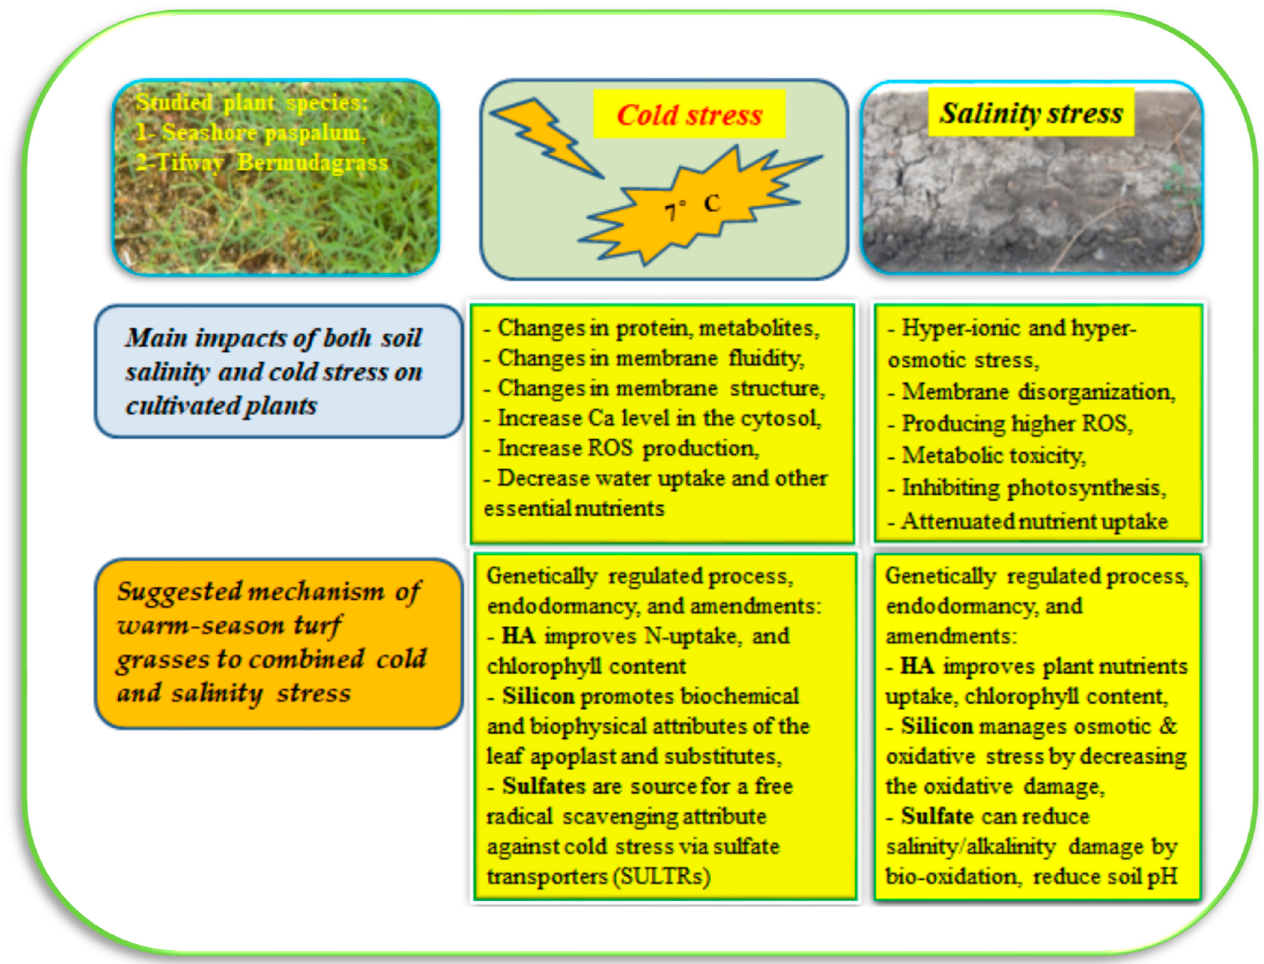
Figure 6. An overview of the suggested main damage to studied plants resulting from both cold and soil salinity and the mechanisms suggested to contribute to tolerance of these stresses (sources: Pompeiano et al. [56], Prokopiuk et al. [57], Sharma et al. [58] Bello et al. [40], Hajiboland et al. [59], Nguyen et al. [60]).